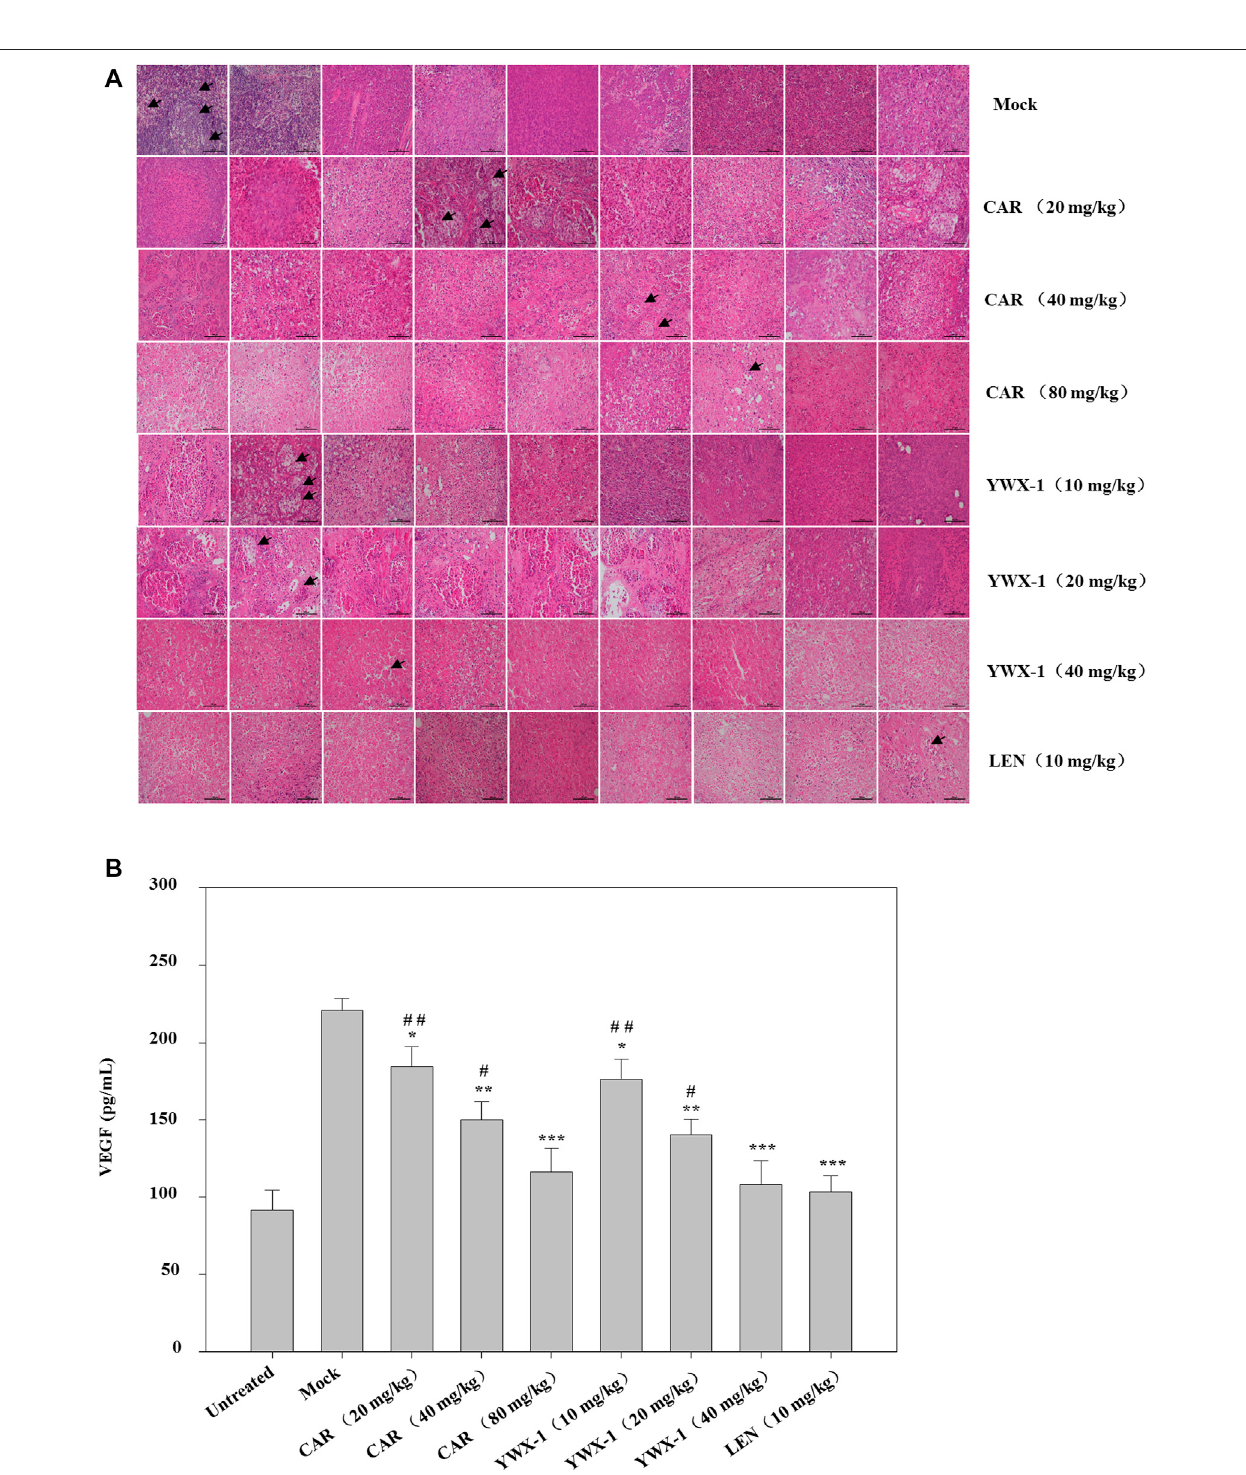
FIGURE 10 | Effect of carrimycin (CAR) and monomeric isovalerylspiramycin I (YWX-1) on the histopathology and VEGF secretion in a subcutaneous xenograft tumor model. (A) Tumor sections were stained with H&E. Histological alterations are indicated by arrows. (scale bar, 100 μ m). (B) The concentration of VEGF in mice serum was detected by ELISA analysis. Data were presented as the mean ± standard deviation of three independent experiments (n=3). * p < 0.05, ** p < 0.01, *** p < 0.001, compared with the mock group; # p < 0.05, ## p < 0.01, ### p < 0.001 compared with the positive control drug lenvatinib (LEN) 10 mg/kg group.